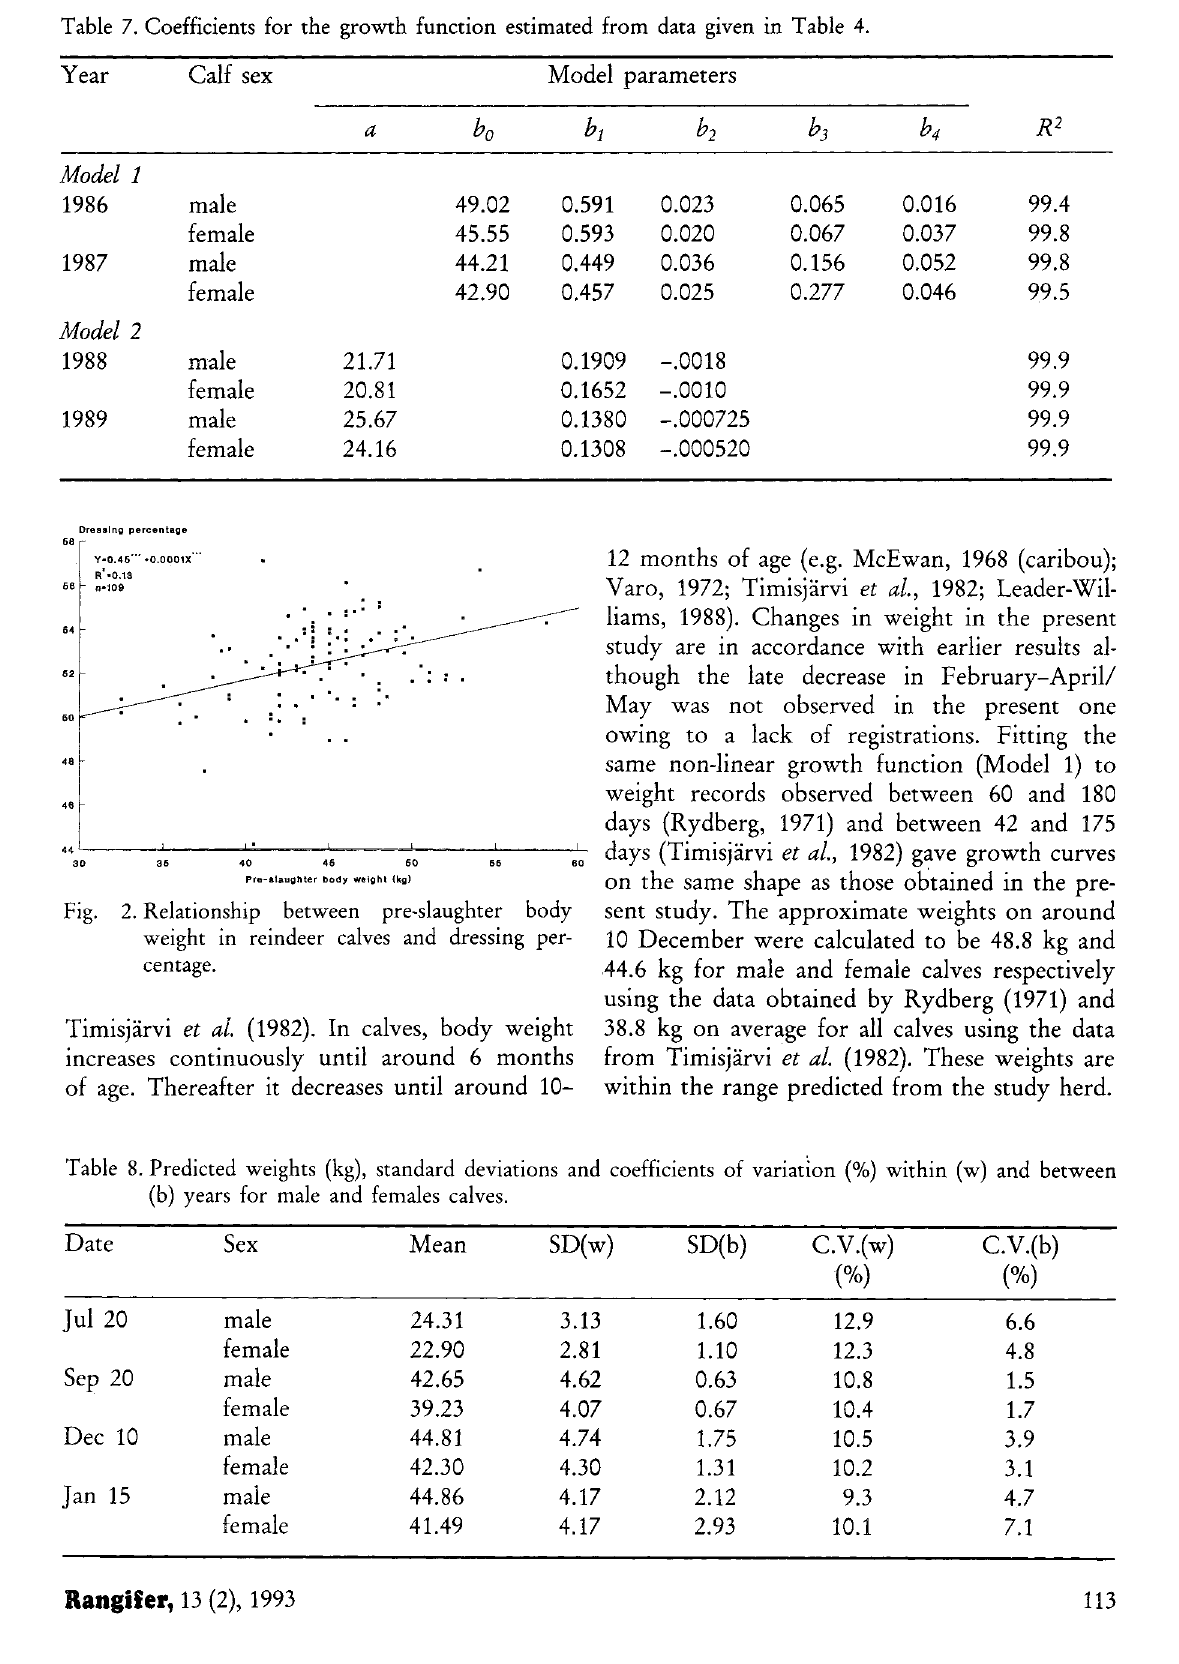
Table 7. Coefficients for the growth function estimated from data given in Table 4.